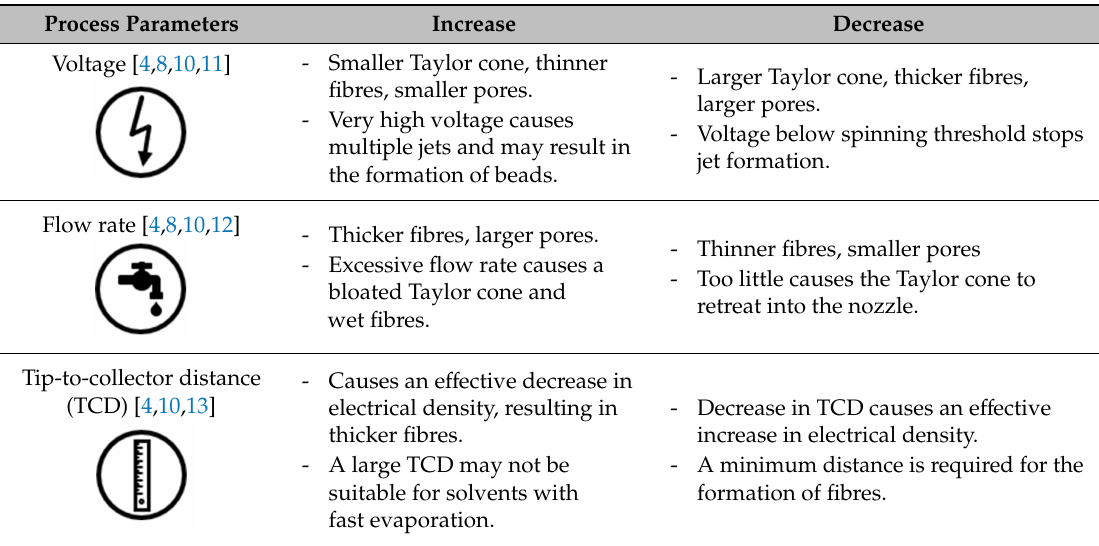
Table 1. Electrospinning parameters and their e ff